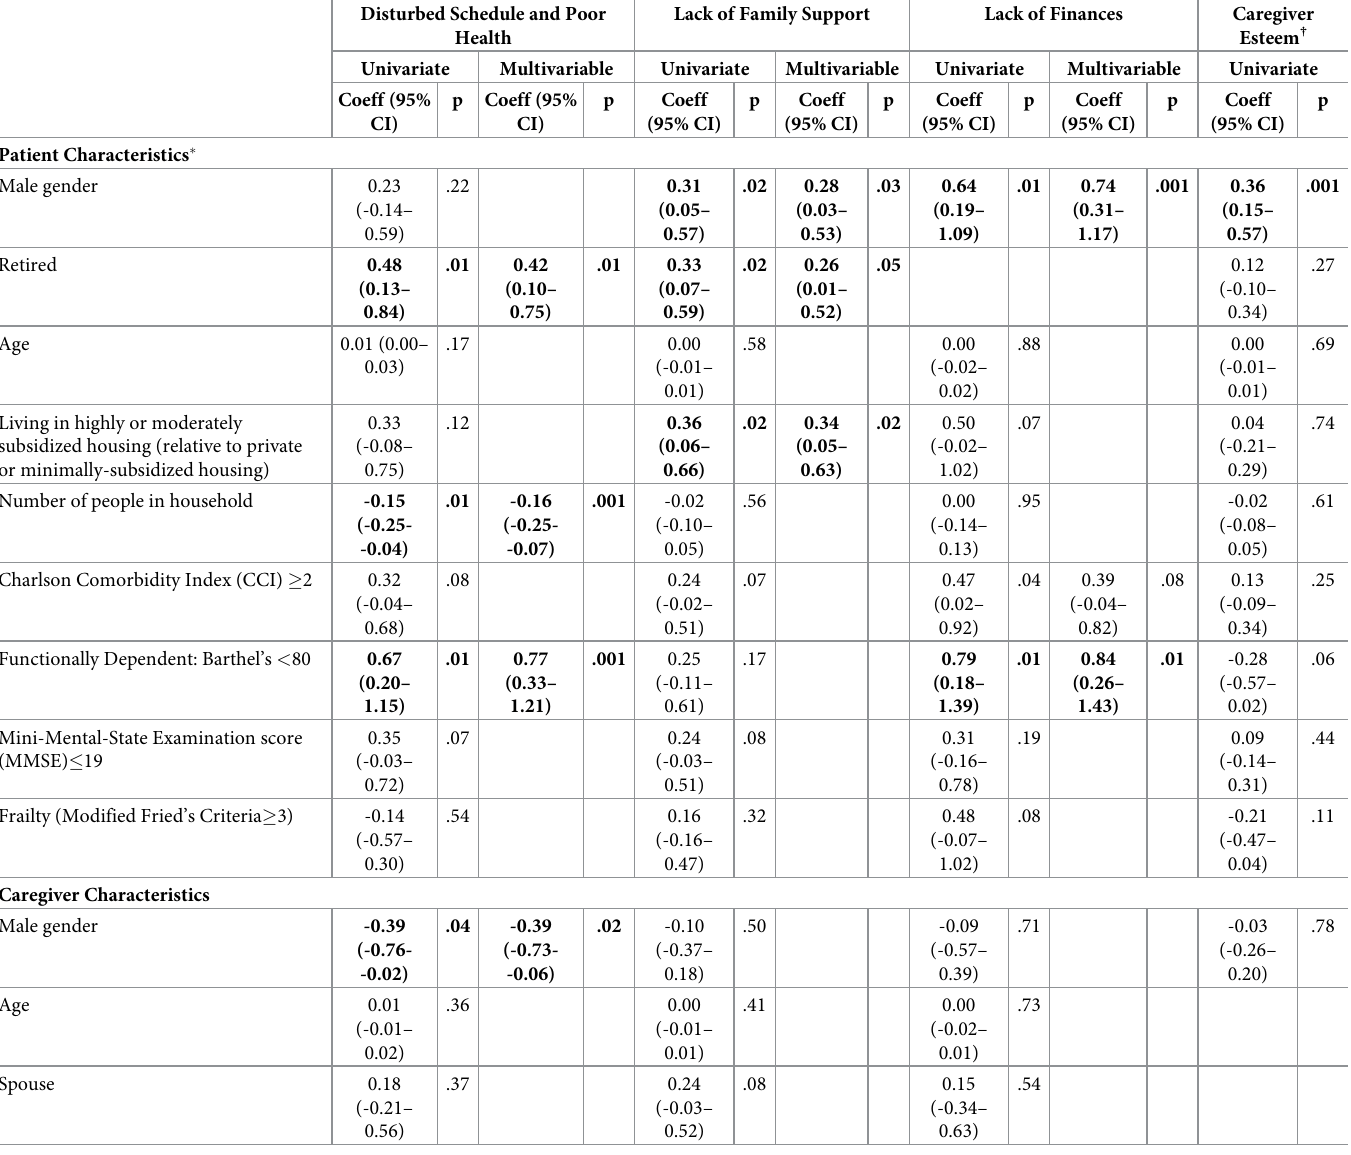
� (Factors highlighted in bold are associated with one or more caregiver domains in multivariable models at 0.05 level of significance) † Multivariable model not shown because only one factor was significant on